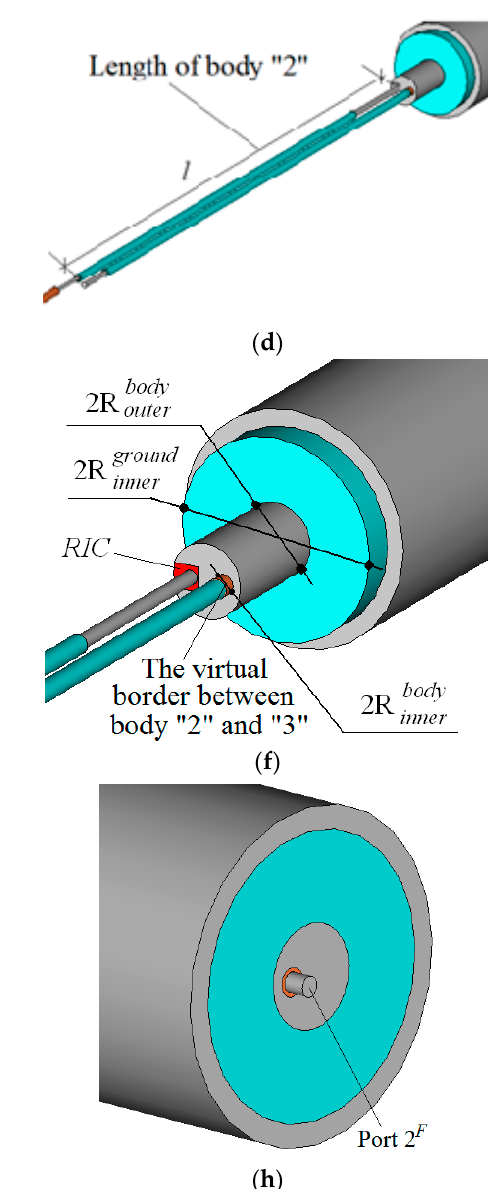
- the first halves of the solid metallic cylinders inside bodies “1” and “3” are surrounded by the orange medium with relative dielectric constant ε rBL = ε rBR = 4: R BL = R BR = 0.308 mm; - the second halves of the solid metallic cylinders inside body “2” are surrounded by the green vacuum filling: R BS = 0.43mm; the inner radius of both solitary holes inside the solid cylinder with a floating potential that plays the role of all three bodies “1”, “2”, and “3” correspondingly connected in echelon: